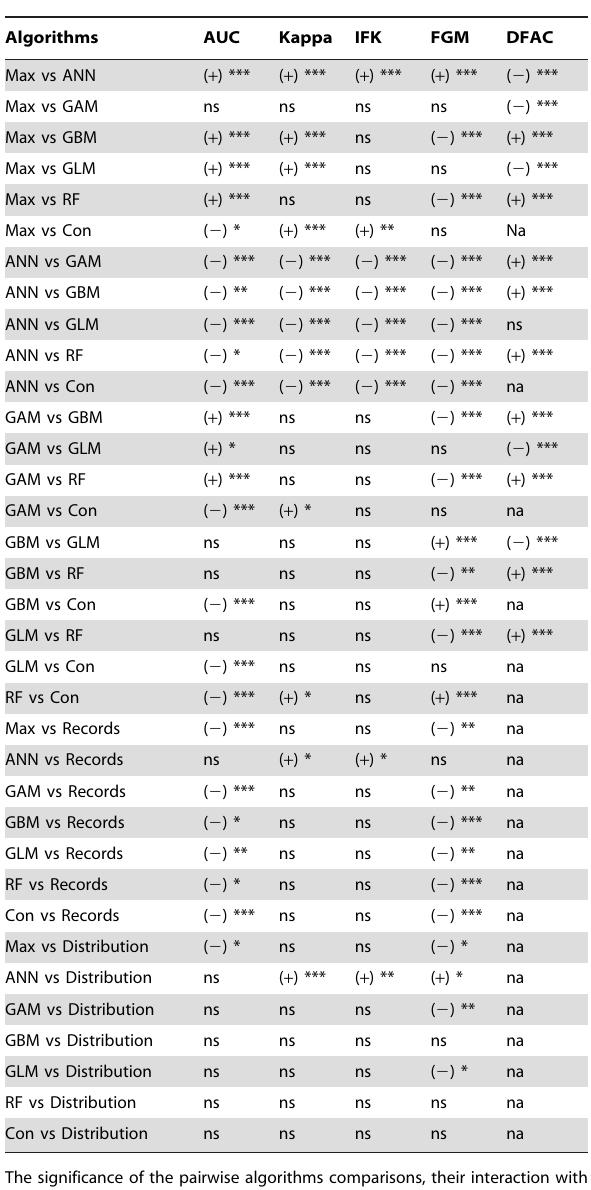
Table 1. Results of the Linear Mixed Effect models for the AUC, Kappa, IFK, FGM and DFAC (deviance from average variable